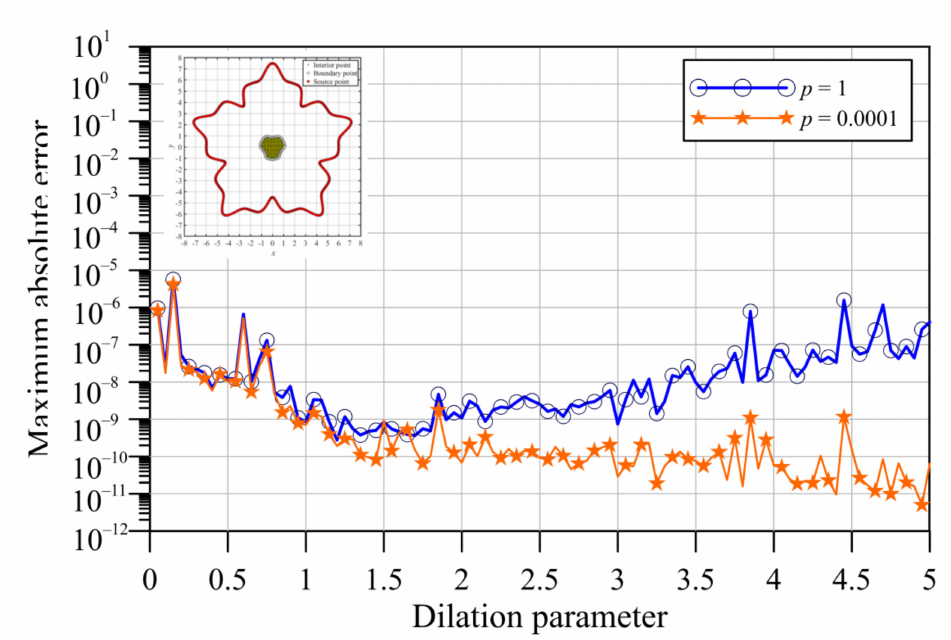
Figure 12. Maximum absolute error versus the dilation parameter ( k = 7 )